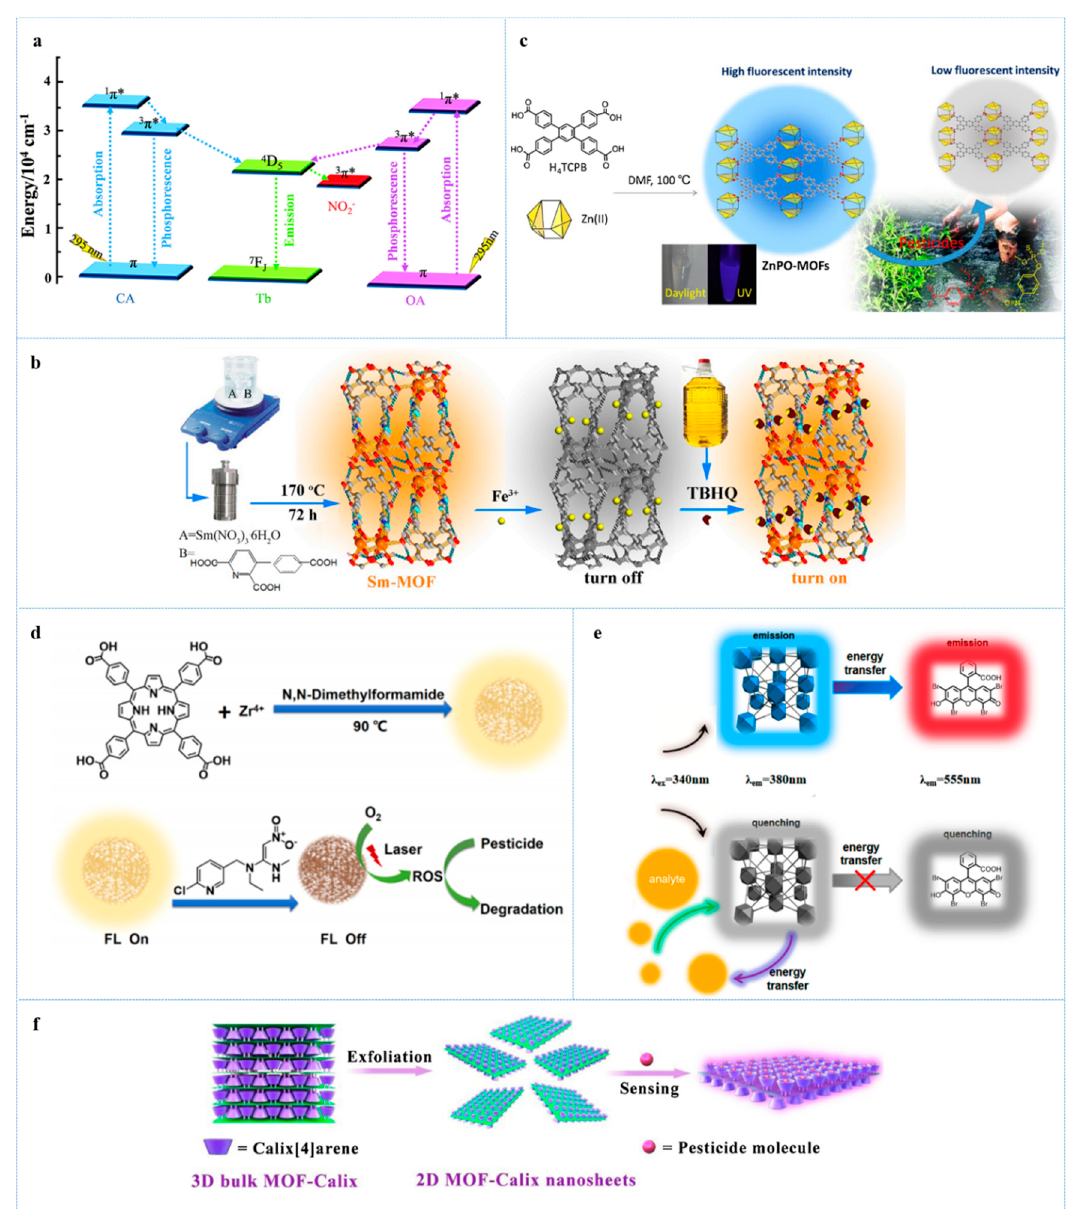
Figure 3. ( a ) the schematic energy transfer process of Tb-MOF in the presence of nitrite, reprinted with modifications from Min et al. [54]; ( b ) the detection mechanism of the “turn off-on” sensor (Sm-MOF) for TBHQ, reprinted with modifications from Liu et al. [59]; ( c ) Schematic diagram for synthesis of ZnPO-MOFs and their application for rapidly detecting organophosphorus pesticides, reprinted with modifications from Xu et al. [64]; ( d ) schematic illustration for the synthesis of FMOF and its fluorescent sensing and photocatalytic applications for NIT residue, reprinted with modifications from Liu et al. [66]; ( e ) schematic illustration showing the mechanism of EY@DUT-52 as a fluorescence sensor for pesticides, reprinted with modifications from Wei et al. [71]; ( f ) schematic illustration for the fabrication of 2D MOF-Calix nanosheets and sensitive detection of pesticide, reprinted with modifications from Yu et al. [72].